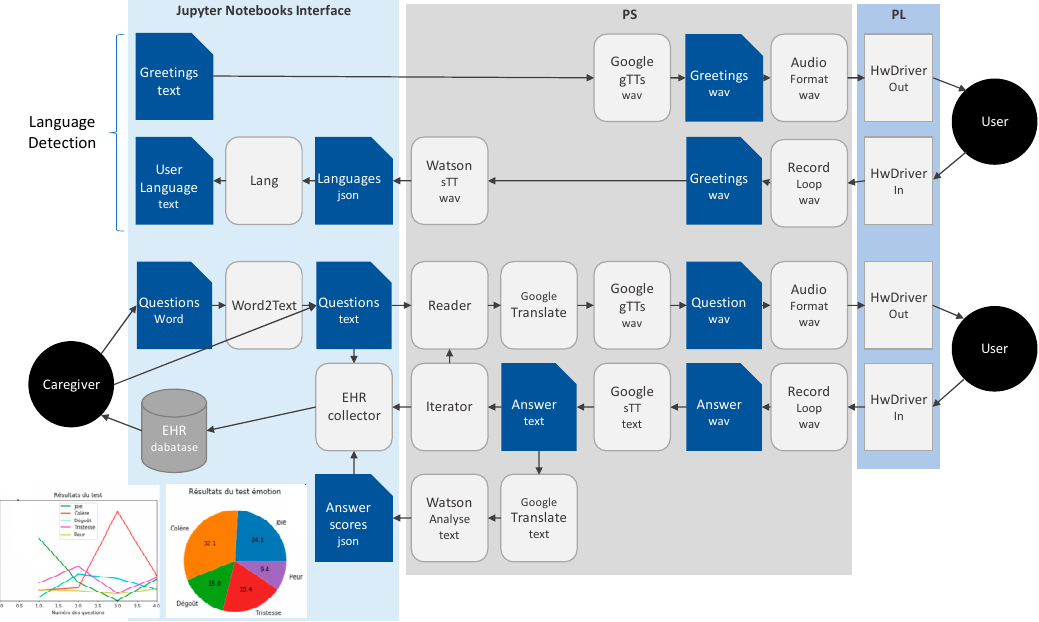
Figure 3. Healthcare home hands-free voice device system architecture. The edge-computing embedded system is composed of three sections: Jupyter Notebook WEB interface, Programmable Software PS and Programmable Logic PL. The PL part includes the headset user interface and real-time audio processing. The WEB interface allows retrieving the results in text and graphical form, in addition to entering queries and advice. The PS part recognizes the user’s language and processes the questions and answers stored in the Electronic Health Record (EHR) database. Note: the screenshot of the WEB interface shows the graphic and circular views in the language chosen by the specialist (therefore automatically translated by the tool into